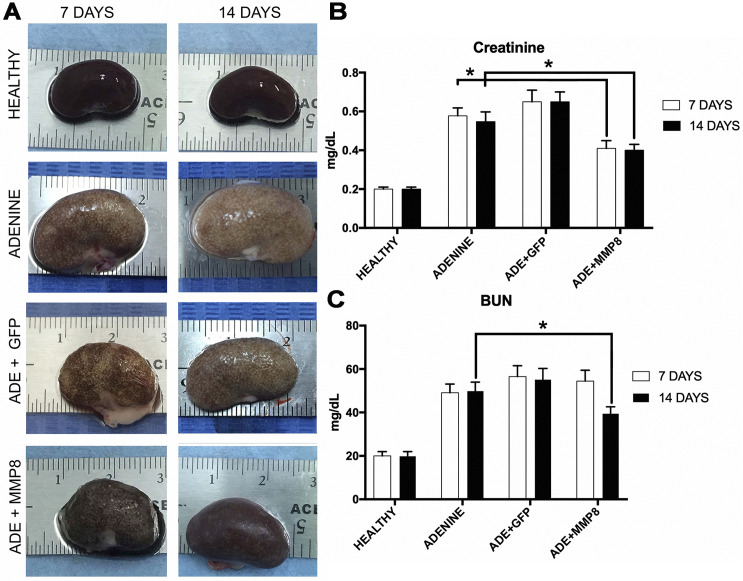
Macroscopic appearance of the kidneys and renal functional tests.A) Image shows representative kidneys of healthy and adenine controls, irrelevant AdGFP and AdhMMP8 treated animals at day 7 and 14 after vector administration. Adenine crystal deposition can be observed in the intoxication model. A notable diminution in adenine deposition can be observed in AdMMP8 treated animals. B) Blood Ureic Nitrogen (BUN) serum levels and C) serum creatinine levels at 7 and 14 days after intervention. * denotes a p<0.05.